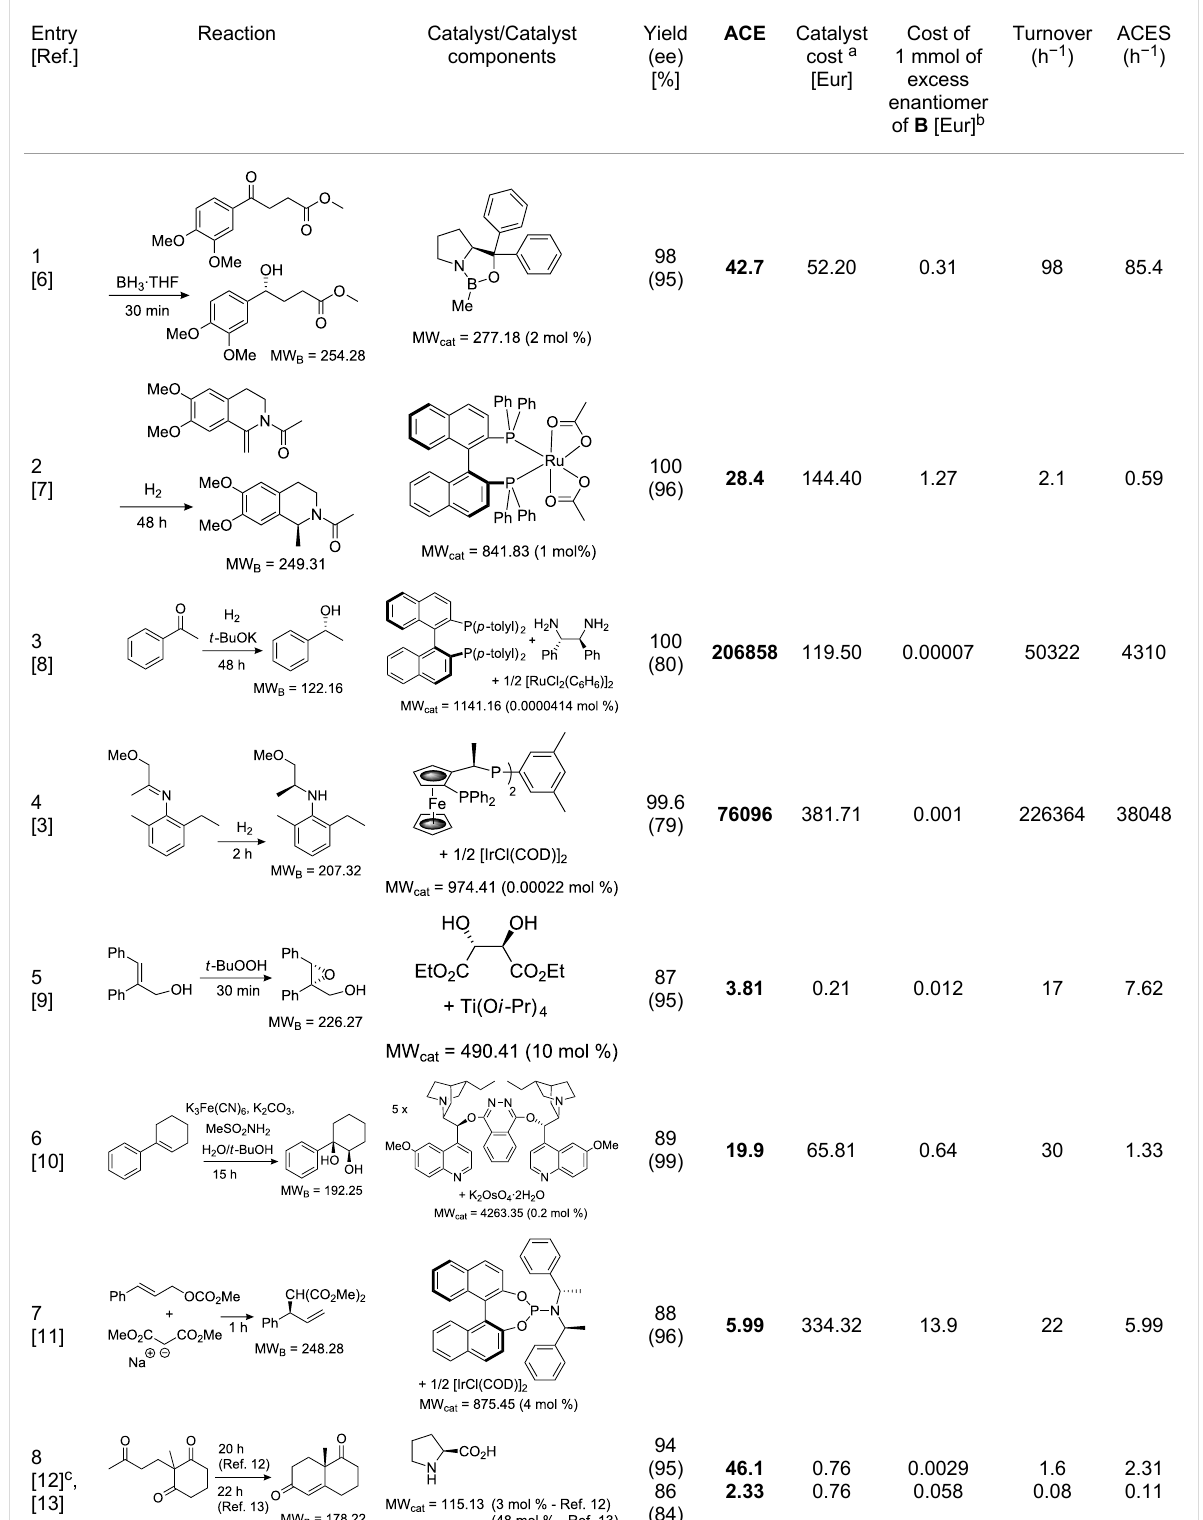
Table 1: Calculation of ACE for various catalytic asymmetric transformations. Entry